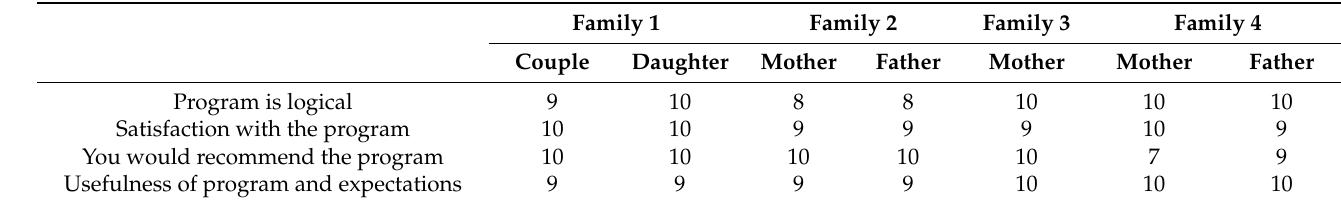
Table 4. Satisfaction and acceptance of FC on the OTSM